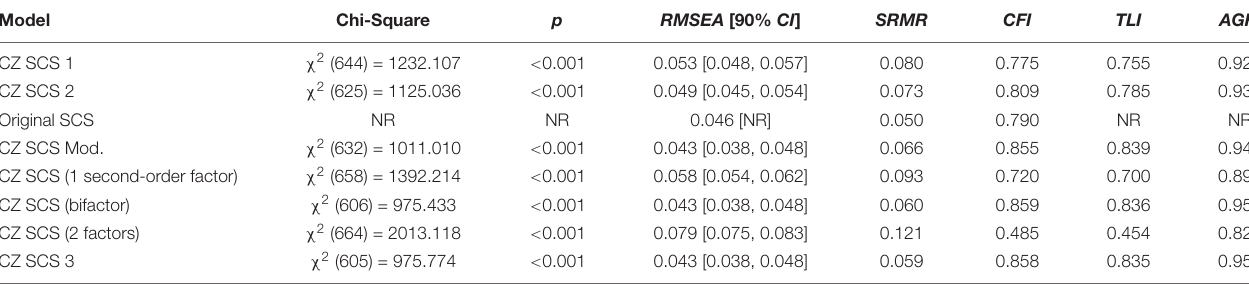
TABLE 3 | The SCS and SCS modified model fit indices compared to the original version by Vignoles et al. (2016). Model